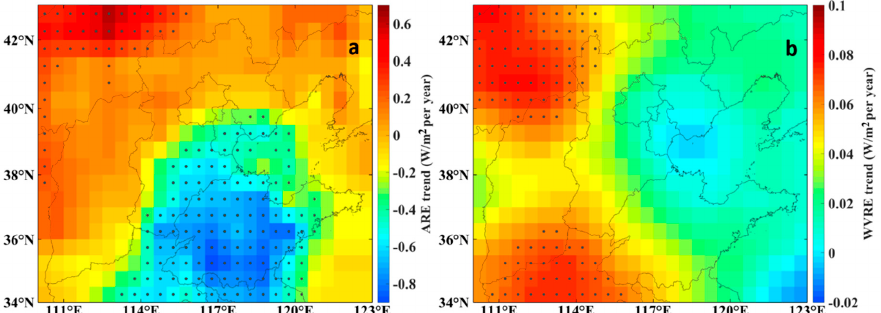
Figure 13. Spatial distribution of deseasonalized trends of ( a ) ARE and ( b ) WVRE in northern China during 2001–2015. Regions with significant trends (p value < 0.05) are indicated by dots.